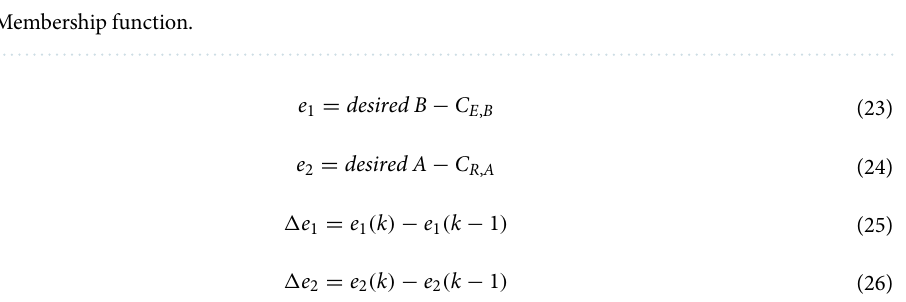
Figure 8. Membership